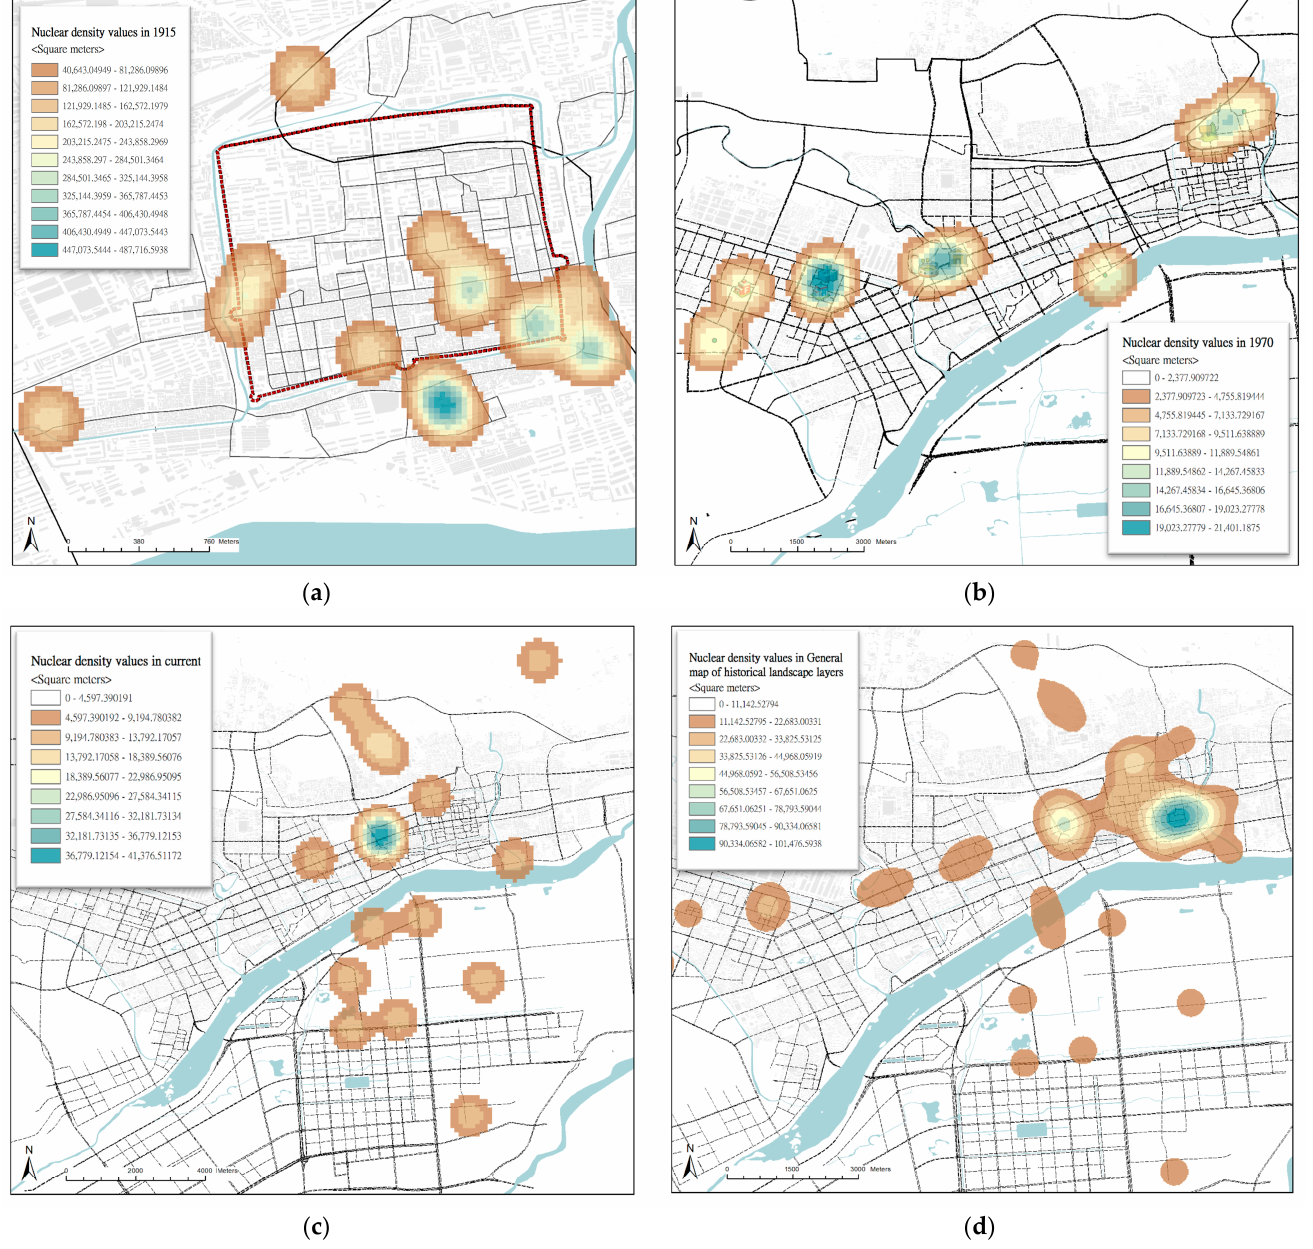
Figure 8. Historical value richness chart: ( a ) in 1915; ( b ) in 1970; ( c ) in the current time; ( d ) stacked graphs (Chart provided by ArcGIS Screenshot).